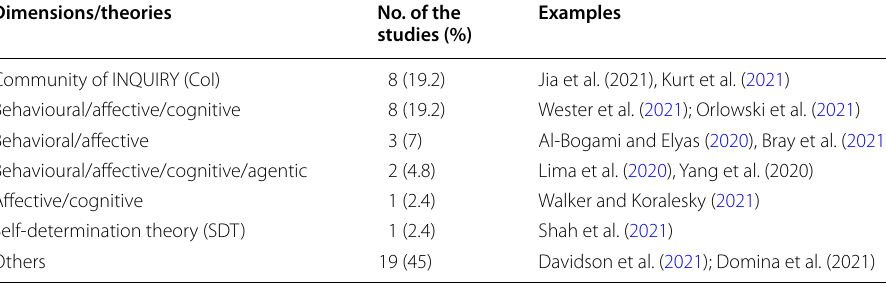
Table 5 Theoretical perspectives of conceptualizing engagement